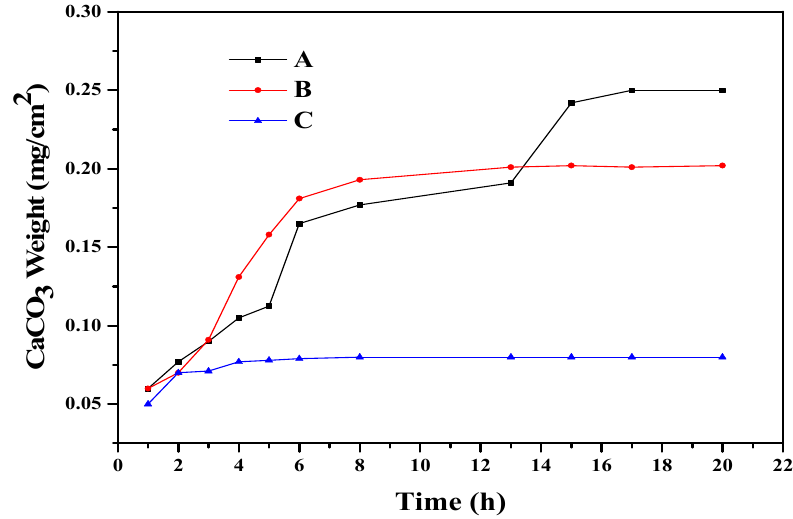
Figure 4. Scaling tendency for untreated, electrodeposited and superhydrophobic brass meshes in hypersaturated calcium carbonate solution. Symbols A, B and C stand for the untreated, electrode- posited and superhydrophobic brass mesh, respectively.